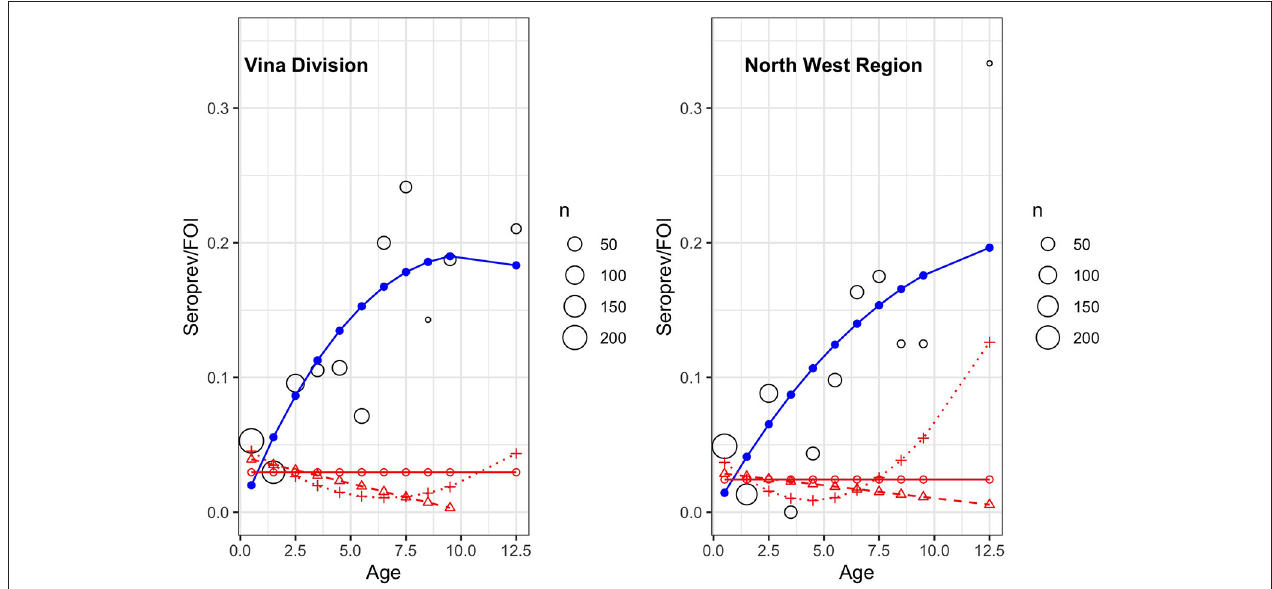
FIGURE 4 | Age-stratified seroprevalence of RVF antibodies in cattle in two sites in Cameroon in 2012. The predicted seroprevalence based on a simple age quadratic function (blue) and the force of infection (FOI) ( λ ) based on the Muench (red circle/solid line), the Griffth’s model (red triangle/dashed line), and the Grenfell Anderson model (red cross/dotted line). The black circles show the mean seroprevalence for that age strata with the size proportional to the number of animals in that age strata.